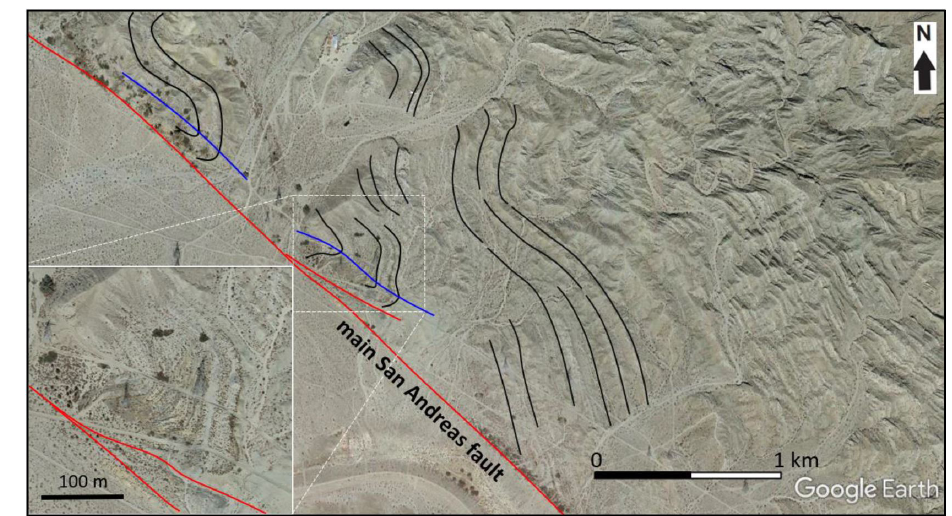
Figure 5. Interpreted SAFZ-parallel macro-folds (synclines) adjacent to the main San Andreas fault, which affect the southern limb of earlier (en echelon) macro-folded and tilted strata of the Palm Spring Formation. Note shear fold geometry in the inset map with a thickened hinge zone and thinned limb to the south, steeply plunging axis, and axial trace parallel to the main San Andreas fault. See Fig. 2 for location. Uninterpreted version of the image available as Fig. S4. © Google Earth